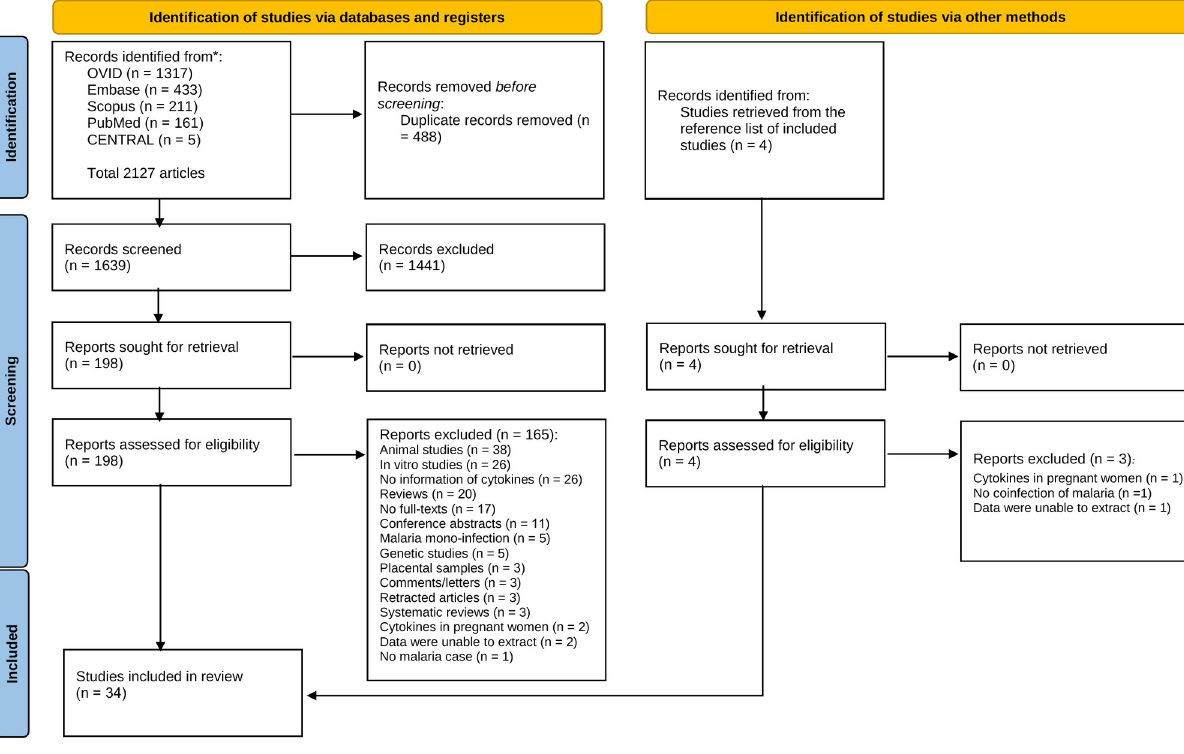
Fig 1. Flow diagram of the study selection